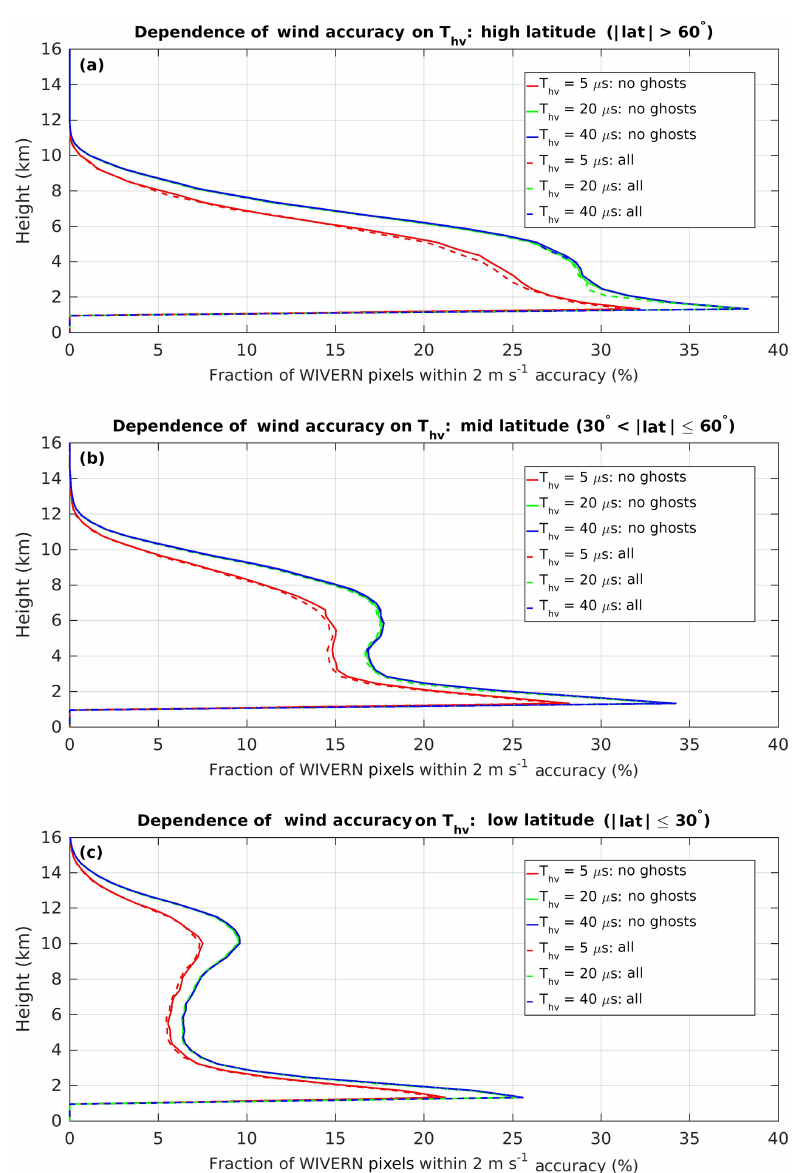
Figure 12. The fraction of profiles (including cloudy and non-cloudy situations) from which winds at a given height can be derived with an accuracy of 2ms − 1 for various T hv values for high latitudes (a) , midlatitudes (b) and tropical (c) oceanic conditions. Dashed (continuous) lines correspond to results when the ghosts are (are not) accounted for. A WIVERN forward configuration has been assumed (see Table 1) with an along-track integration length of 20km. The WIVERN profiles have been reconstructed from CloudSat profiles over ocean with LDR and clutter signals reconstructed based on airborne observations of ocean surface